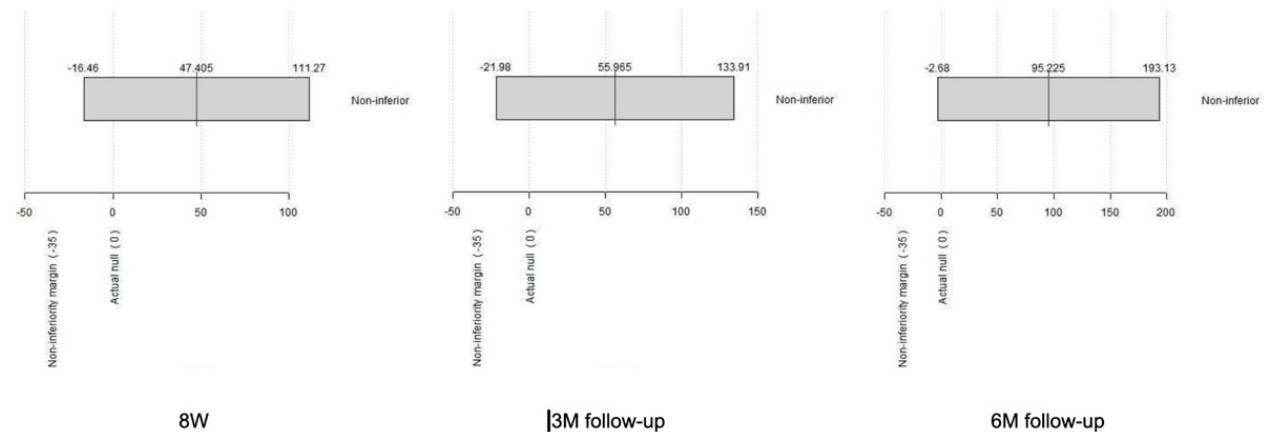
Figure 3. Non-inferiority test regarding the 6 min walk test distance between baseline and after 8 weeks of rehabilitation and after 3 and 6 months of follow-up. Data are shown as the mean difference between groups and 95% confidence